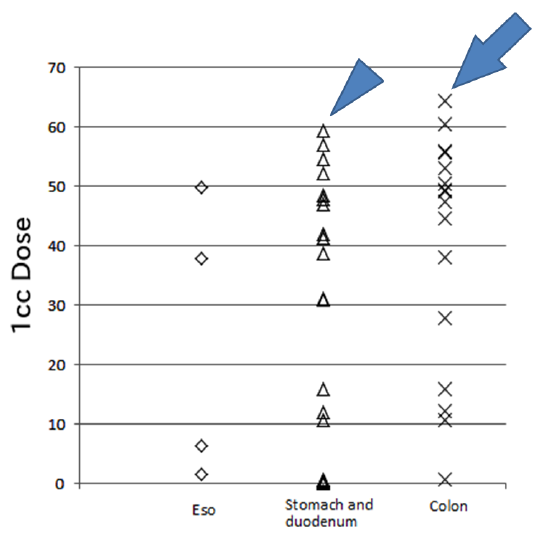
Figure 3. The 1-cc dose of the gastrointestinal tract. One case (arrowhead) involved a high dose (59.3 CGE) per 35 fractions to the stomach and duodenum, resulting in gastric hemorrhage with an ulcer treated by transfusion (grade 3). Another case (arrow) involved a high dose (64.4 CGE) per 20 fractions to the transverse colon without acute or late toxicity during the 3-year follow-up. Eso: esophagus, CGE: cobalt gray equivalent.